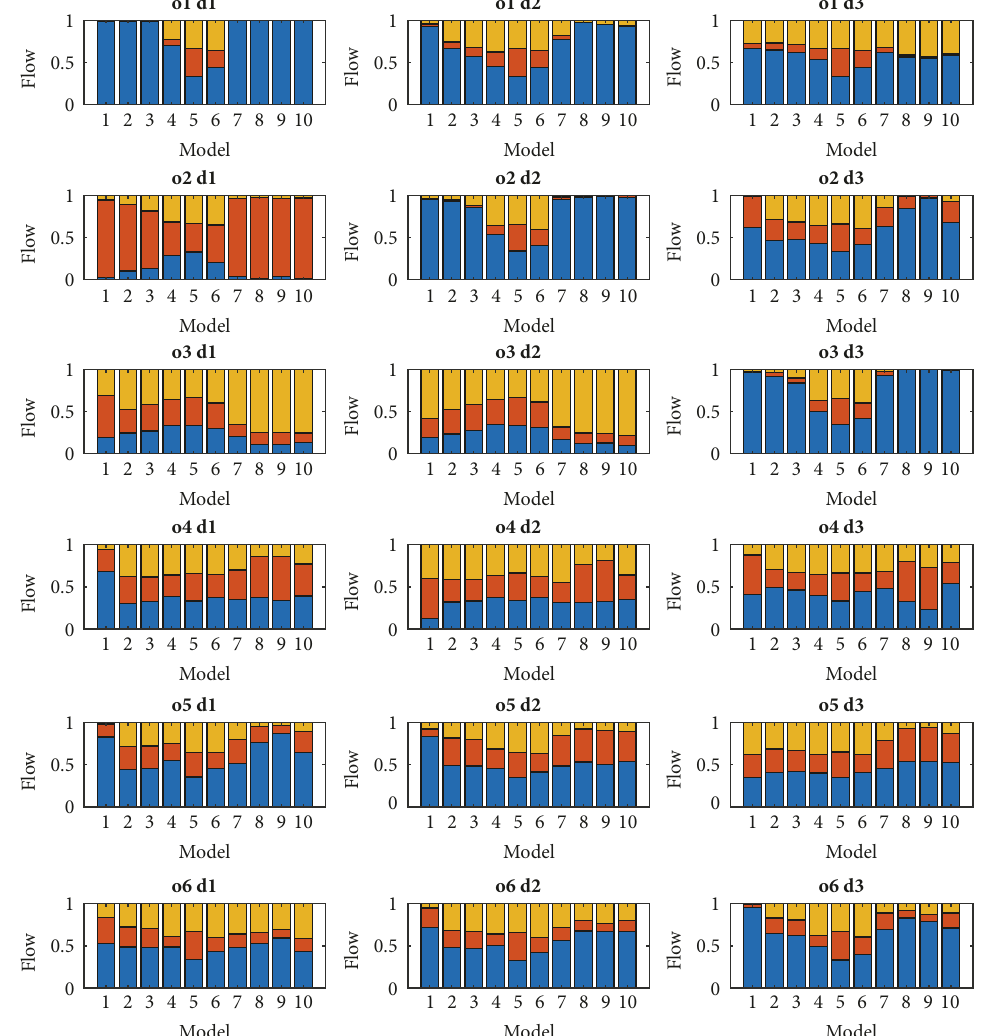
Figure 4: Route flow distributions for the 10 simulation scenarios and for the od pairs: 𝑜 = 1,. .. ,6 and 𝑑 = 1,2, 3 . Each simulation scenario is identified by the Model ID equivalent to the ID values listed in Table